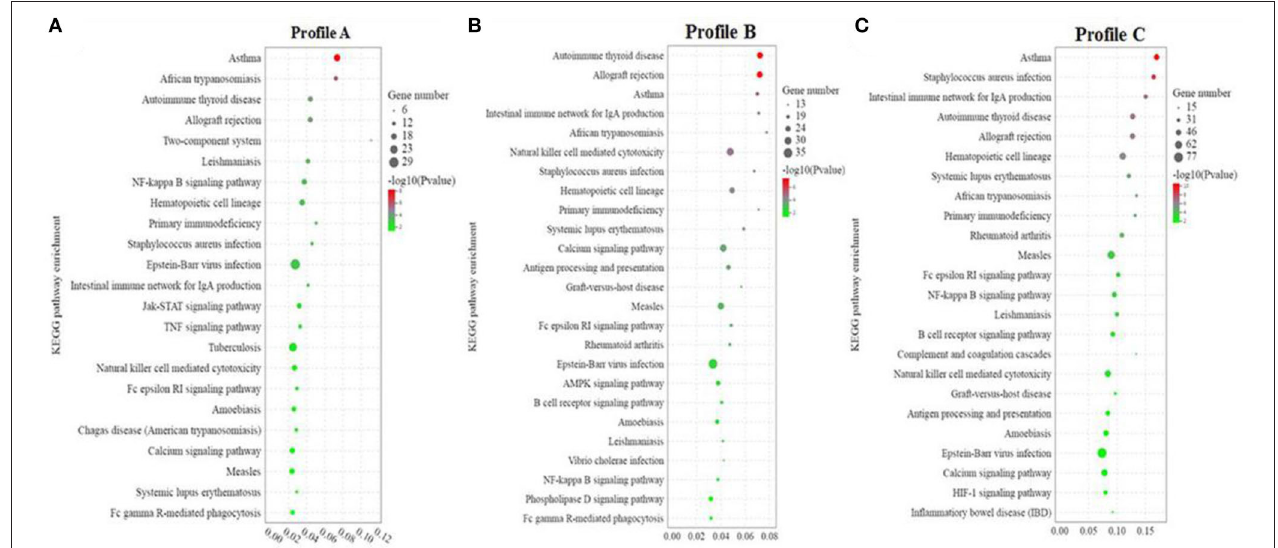
FIGURE 5 | (A–C) KEGG enrichment analysis of significant differential genes between soybean meal and fermented soybean meal in hindgut of pearl gentian grouper ( n = 4).